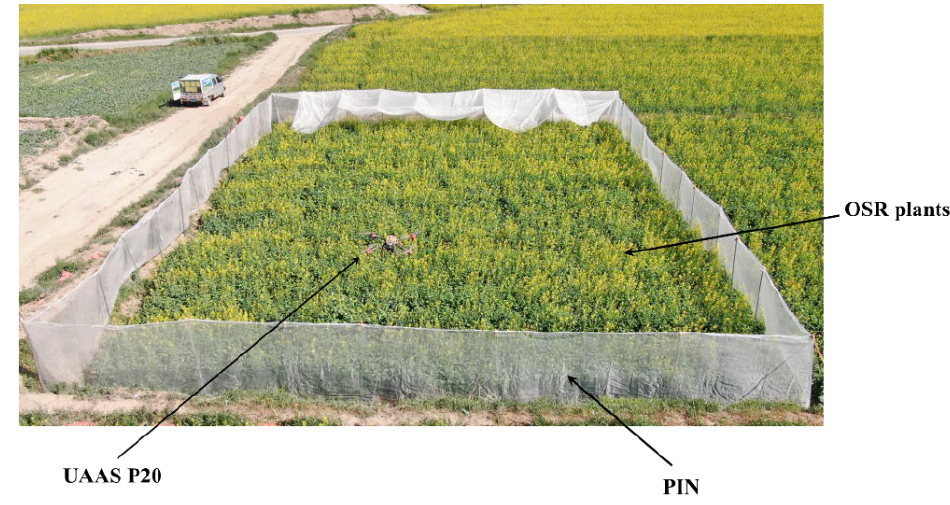
Figure 1. The UAAS P20 flying in the UAAS pollination area.